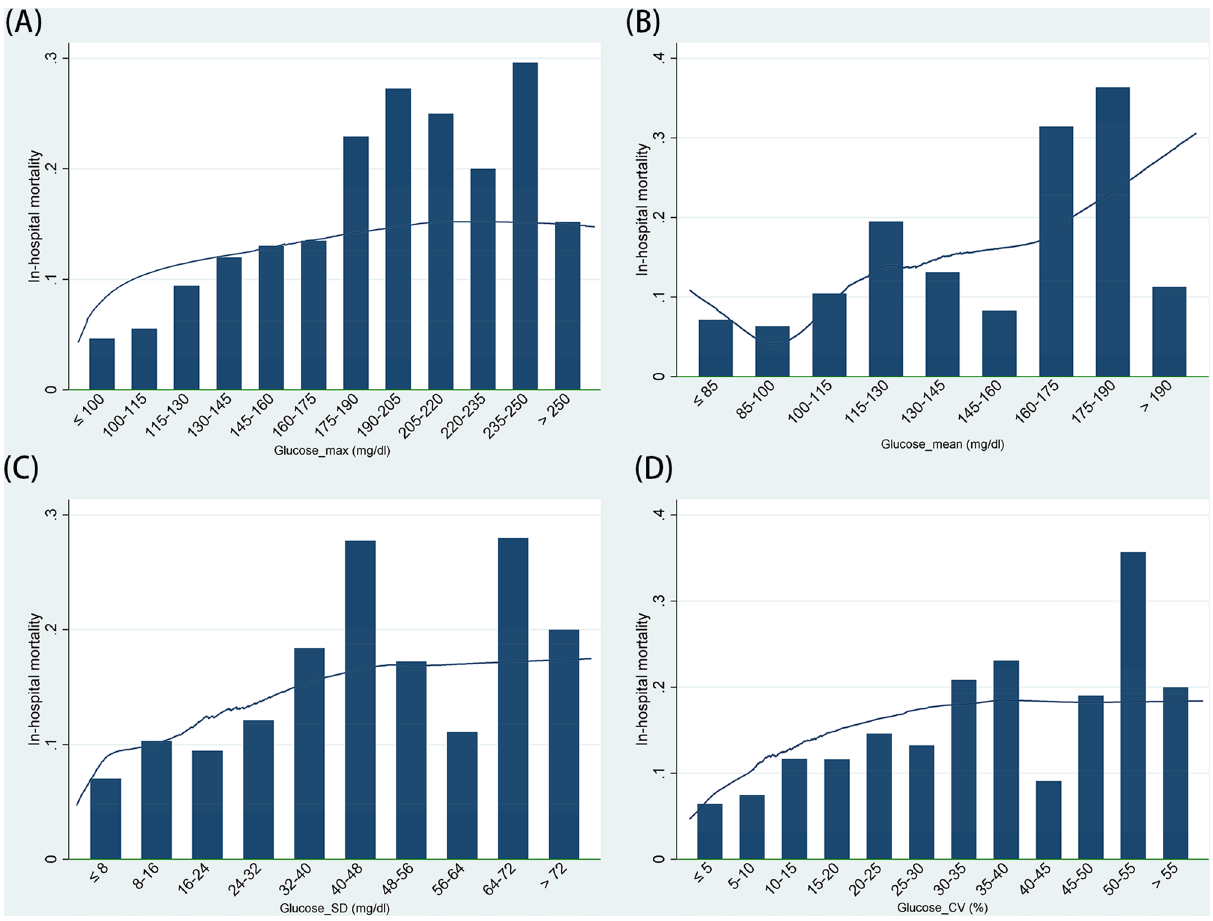
Figure 3. Lowess smoothing curve of the association between Glucose_max/Glucose_mean/Glucose_SD/ Glucose_CV and in-hospital mortality. The Lowess smoothing curve demonstrates that there is a nonlinear relationship between ( A ) Glucose_max/( B ) Glucose_mean/( C ) Glucose_SD/( D ) Glucose_CV and in-hospital mortality in patients with acute